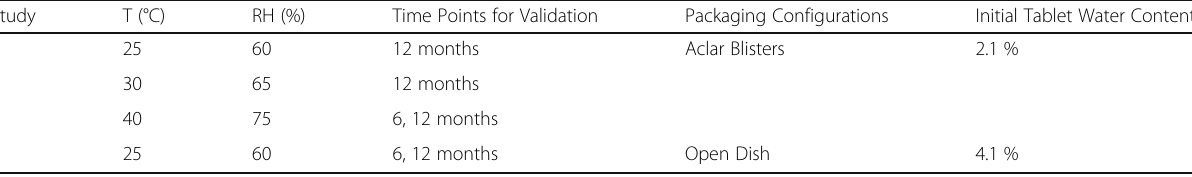
Table 2 Stability studies/conditions used for external model validation Study T (°C) RH